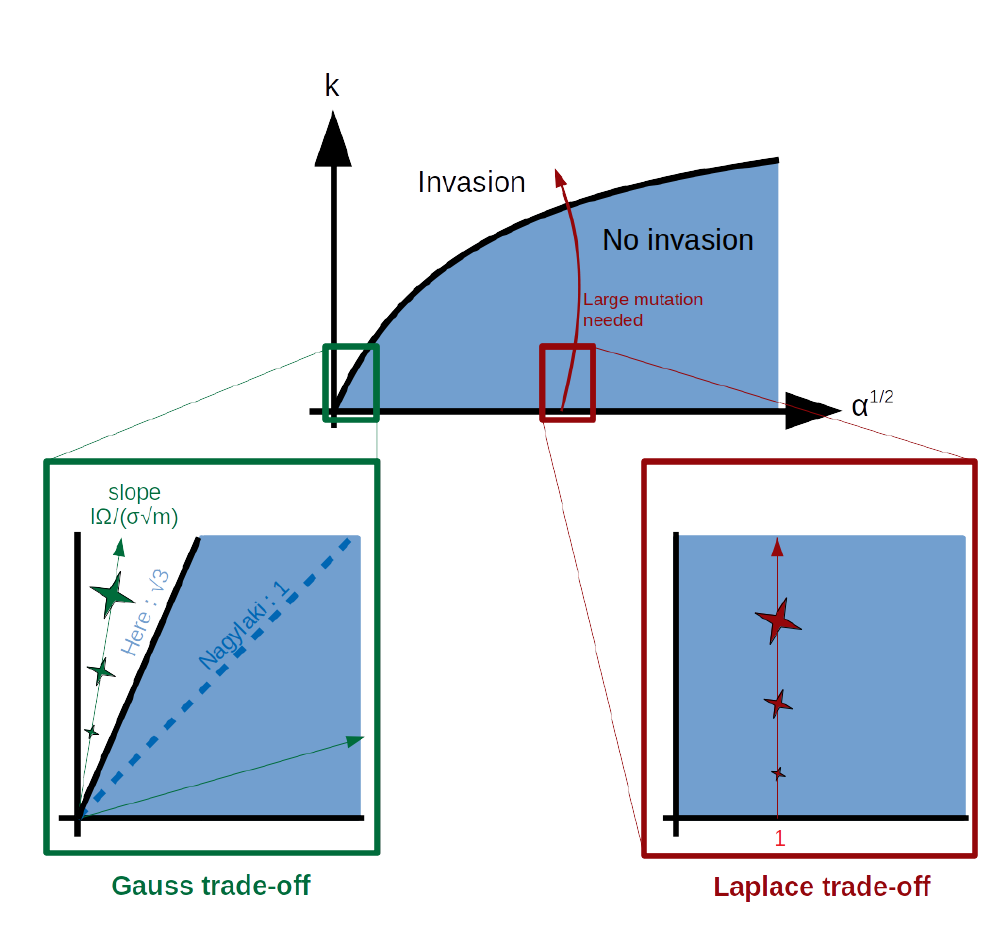
Figure 4 - Conditions for polymorphism in the semi-infinite limit of our model. The upper panel correspond to the condition for the existence of a cline in an habitat ‘pocket’ as predicted using (Nagylaki, 1975). See Lenormand (2002), Box 2, fig. II. The figure shows whether a mutant can invade (white area) or not (blue area) the 𝑧 = 0 resident phenotype as a function of two compound parameters 𝑘 , and 𝛼 (if it does, a cline establishes between the habitats). On the y-axis 𝑘 measures the relative scales of the spatial heterogeneity (width of the pocket 𝑙 ) and of the ‘characteristic length’ ( 𝜎√𝑚/ √𝑆 2 (𝜀) ), which weighs the strength of selection relative to gene flow. On the x-axis, 𝛼 1/2 measures the square root of the ratio of selection coefficients outside/inside the pocket. The lower panels zoom on areas of the figure where small mutants are positioned with a Gauss (green, left) and Laplace (red, right) fitness trade-off. In both panels, mutation with increasing phenotypic effects are presented using stars with increasing size. In the Gauss case, mutations of different effect sizes follow lines with zero intercept and slopes that depend on the parameters (see eqs. 11, 12a, 12b). Mutants can invade if this slope is above the critical slope corresponding to the frontier between the blue and white areas. This is an all- or-nothing situation. Mutations of small and large effects can either all invade or none of them can invade. In the Laplace case, mutations are on a vertical line with 𝛼 = 1 (symmetry between habitats). Infinitesimal mutations cannot invade, but large mutations can form clines if their phenotypic effect is sufficiently